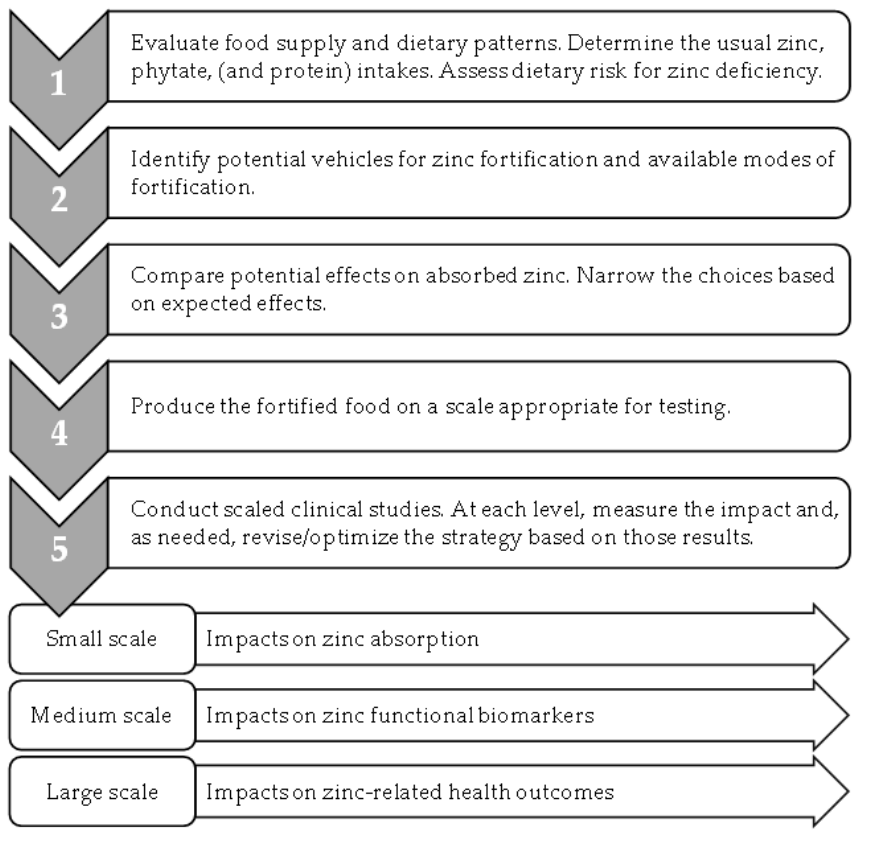
Figure 2. Optimizing zinc fortification